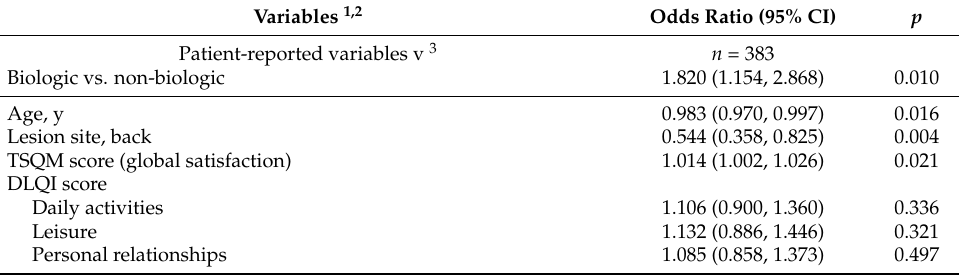
Table 4. Regression analysis of factors associated with treatment